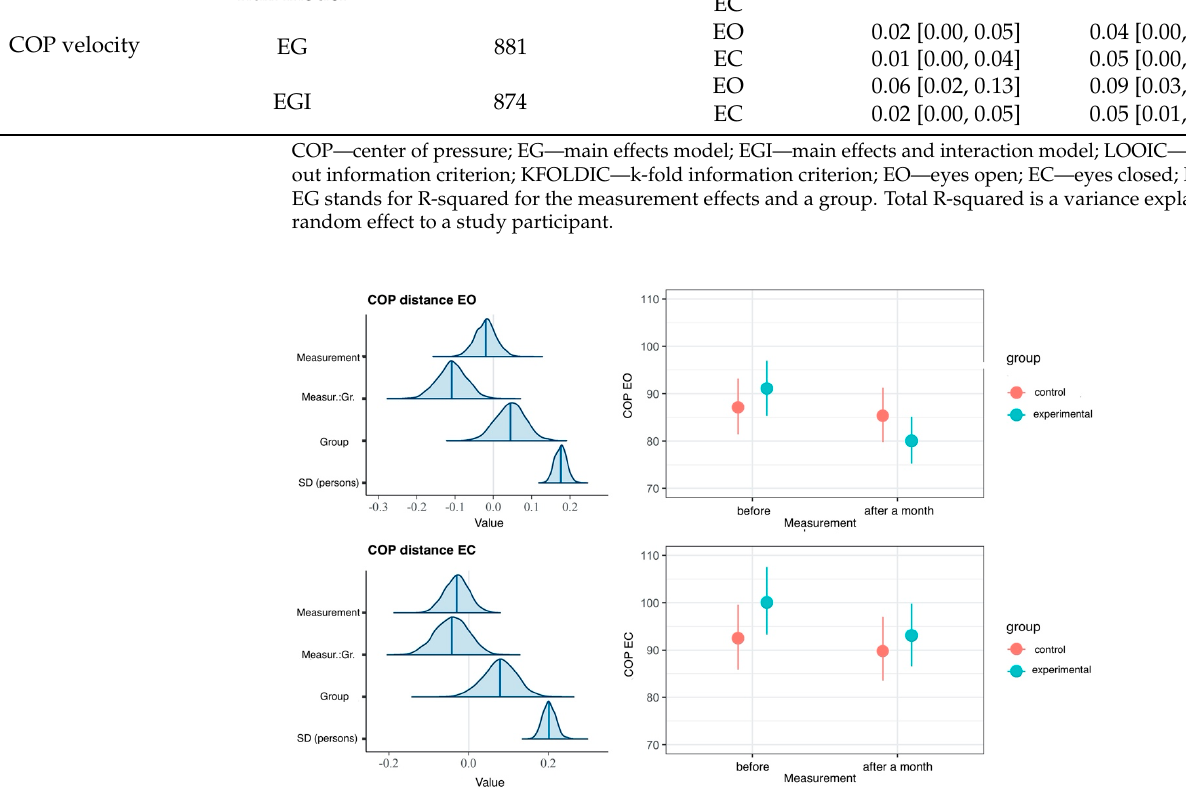
Figure 5. Results of hierarchical two-dimensional regression analysis: the dependent variable is the COP distance, whereas the predictors are the dependent variable and the group. Left panels: a posteriori distributions of regression coefficients. Shaded areas denote 95% confidence level. Right panels: estimated marginal means. The points denote a posteriori distribution mean values, and vertical lines represent 95% confidence intervals. COP—center of pressure; EO—eyes open; EC—eyes closed; Measur.:Gr.—Measurement: Group.